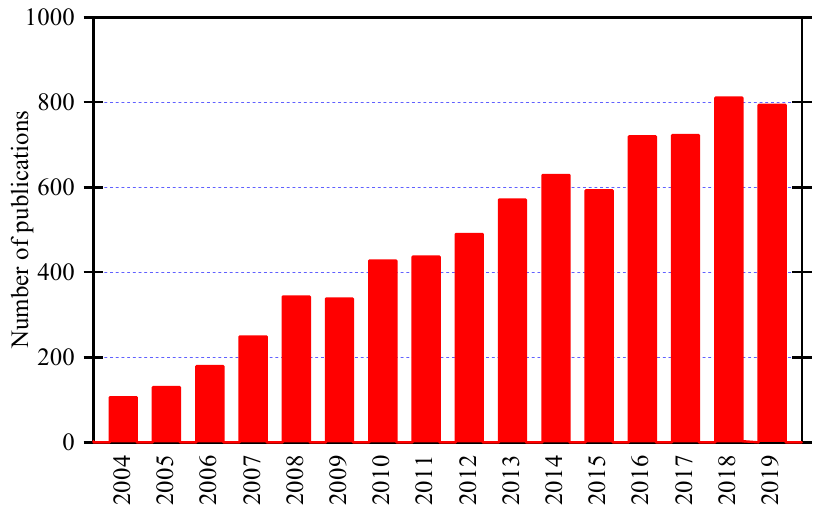
Figure 1. Annual publications on nanocomposites based on polyethylene and polyvinylchloride according to Web of Science database.